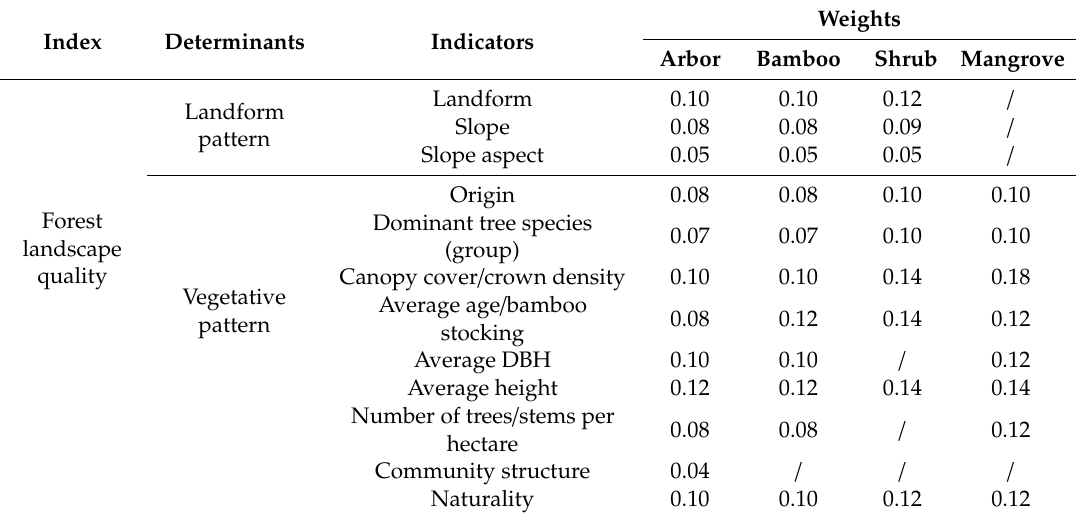
Table 2. Indicators and weights of FLQ.